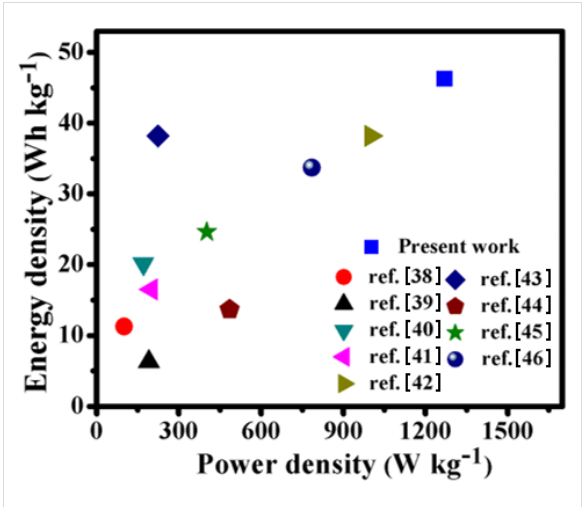
Figure 14: Ragone plot for the SSHSC and comparison with previous literature.